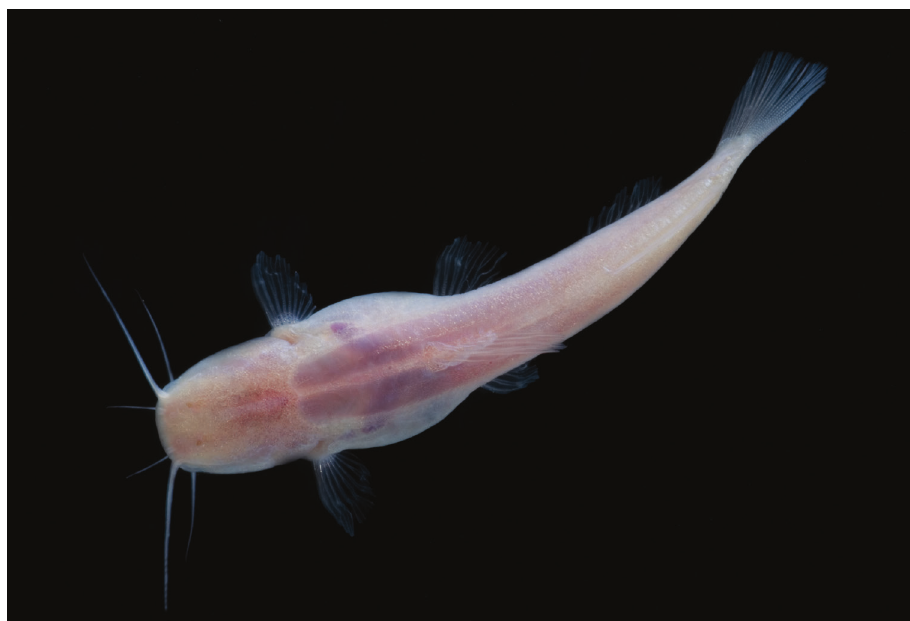
Figure 5. Highly troglomorphic catfish, genus Rhamdiopsis (Siluriformes: Heptapteridae), a relict from Campo Formoso karst area, northeastern Brazil (Photo: Dante